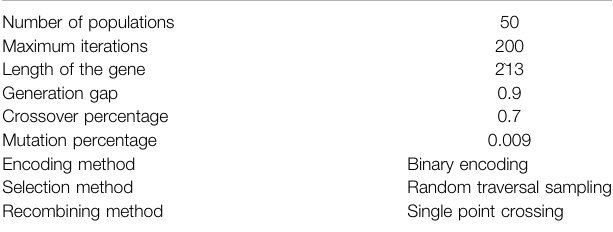
TABLE 4 | Methods and parameters of GA.